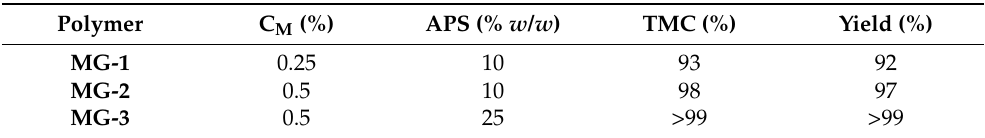
Table 4. Total monomer concentration (C M , % w/w ) and ammonium persulfate (APS % w/w , based on the total moles of the double bonds) values investigated for microgels (MGs) prepared in D 2 O together with total monomer conversions (TMC) and chemical yields. Feed composition for all polymerizations: 4VI (10 mol%), AM (40 mol%), and MBA (50 mol%).